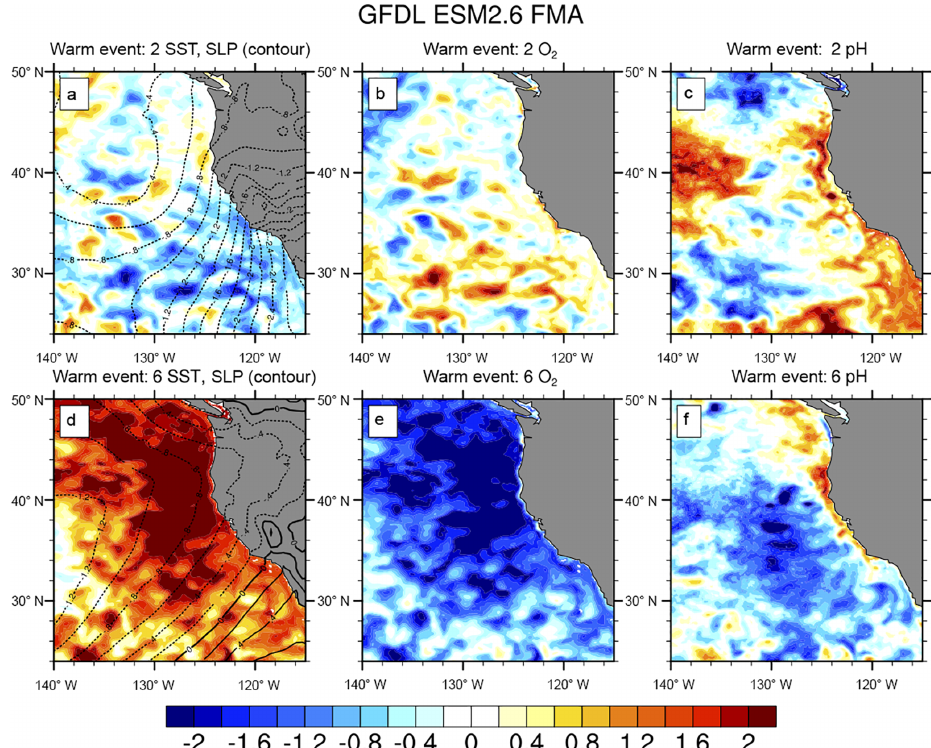
Figure 4. ESM2.6 FMA high-pass-filtered standardized anomalies (unitless) for two warm El Niño events based on NDJ Niño3.4 anoma- lies: (a–c) event 2 and (d–f) event 6, with panels (a) and (d) displaying sea surface temperature with sea level pressure (0.2 σ interval contours), (b) and (e) surface O 2 , and (c) and (f) surface